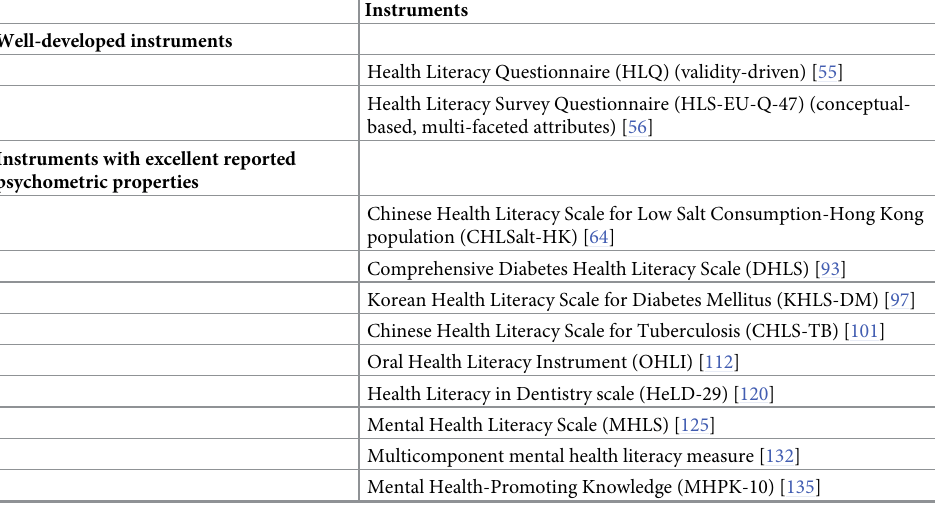
Table 9. A list of instruments that well developed, reported proper psychometric properties, and instruments fre- quently translated or validated in other countries